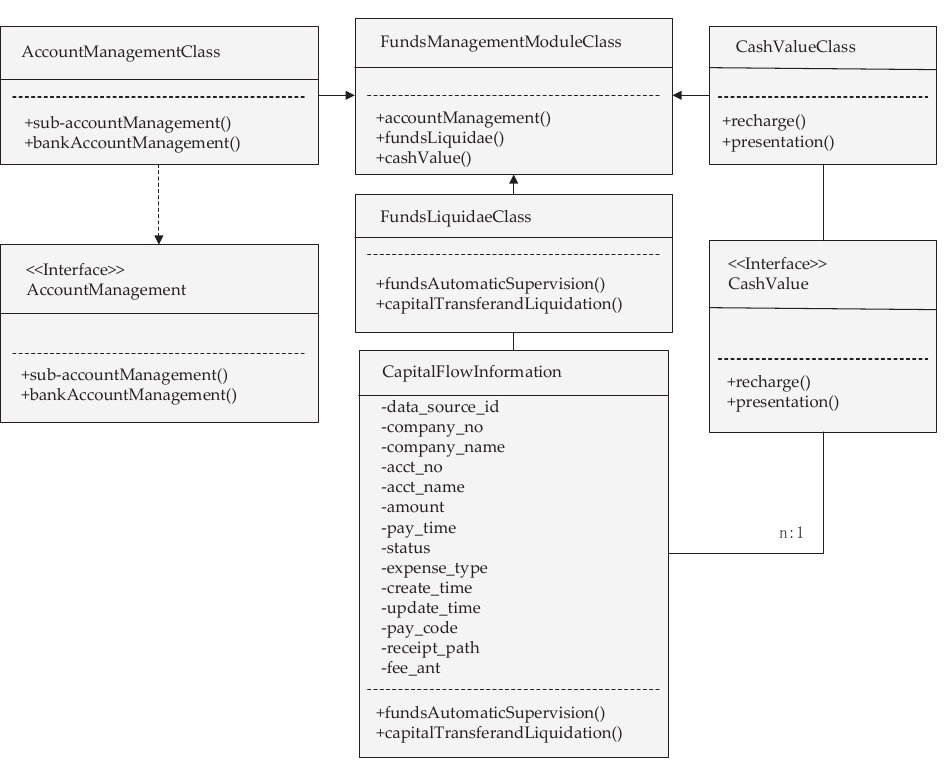
Figure 10. Funds management class